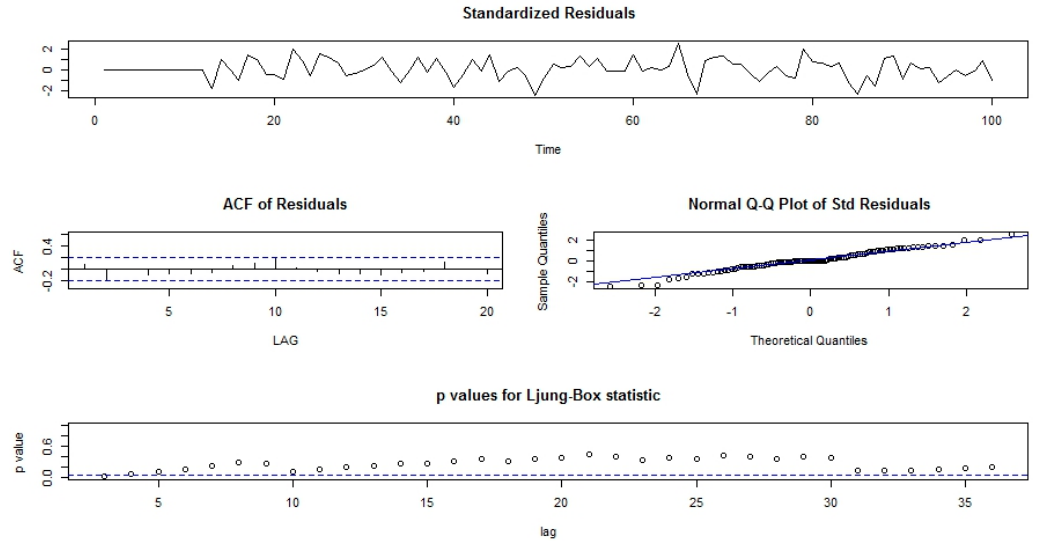
Figure 6. Standardized residuals from the SARIMA model applied to TB prevalence.